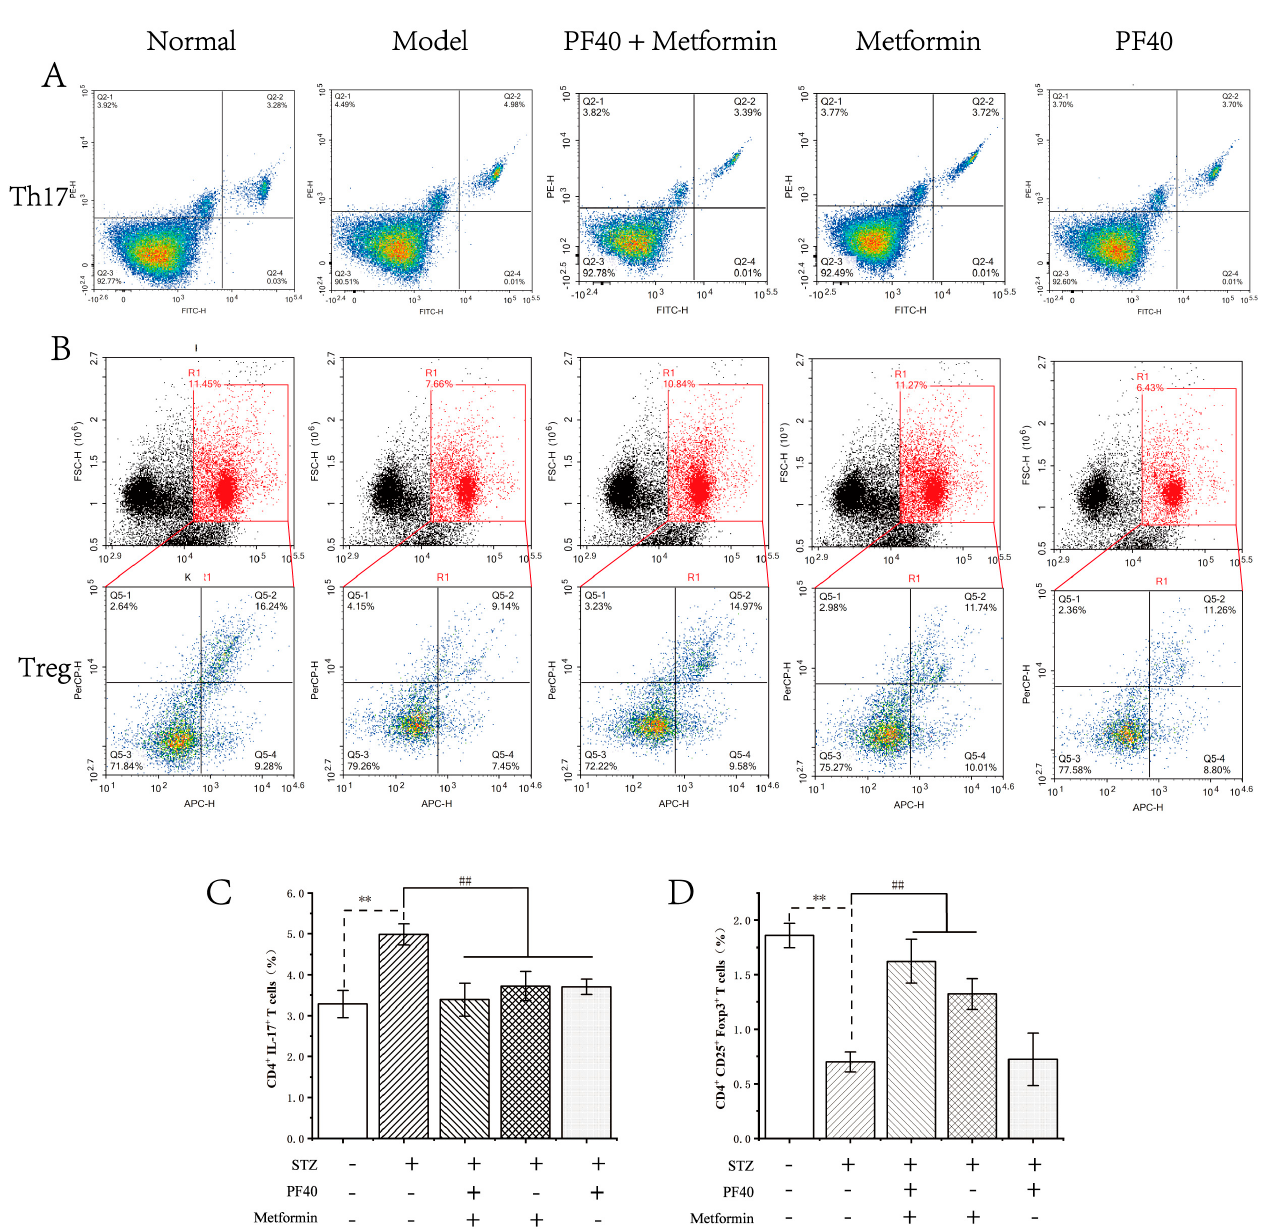
Figure 11. Effects of PF40 on the proportion of Th17 and Treg cells in the T2DM rats ( n = 5): ( A , B ) proportion of Th17 and Treg cells from mice jejuna tissue using the flow cytometry assay; ( C , D ) statistics analysis of the proportion of Th17 and Treg cells. Data are presented as the M ± SD ( n = 5 per group). ** p < 0.01, compared with normal group; ## p < 0.01, compared with model